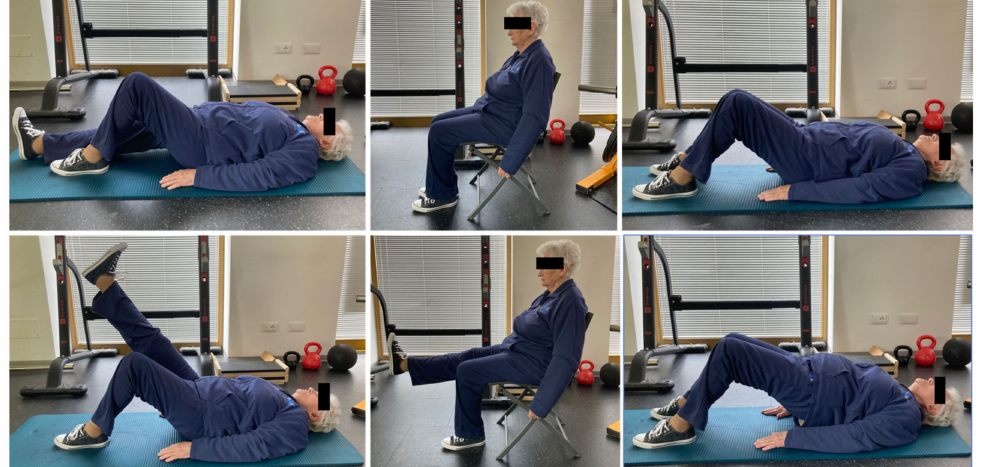
Figure 1. Physical exercise performed by a study